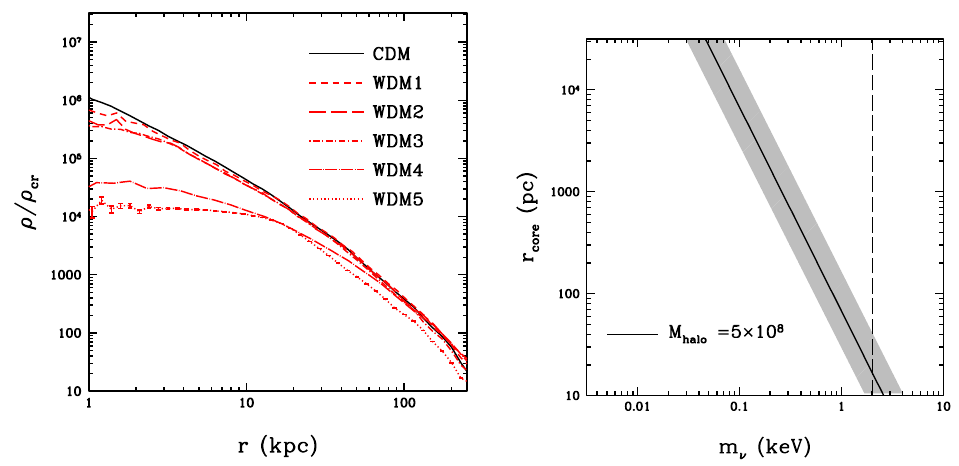
Figure 9. Left panel: comparison of a CDM density profile (solid black line) with five WDM models’ profile ranging from m = 2 keV (WDM1) to 0.05 keV (WDM5). Right panel: core radius obtained in terms of the WDM particle mass. The shaded band corresponds to allowed cosmological values 0.15 < Ω m < 0.6. The vertical line represents the upper limit WDM mass, constrained from large scale observations (reproduced from [339]).